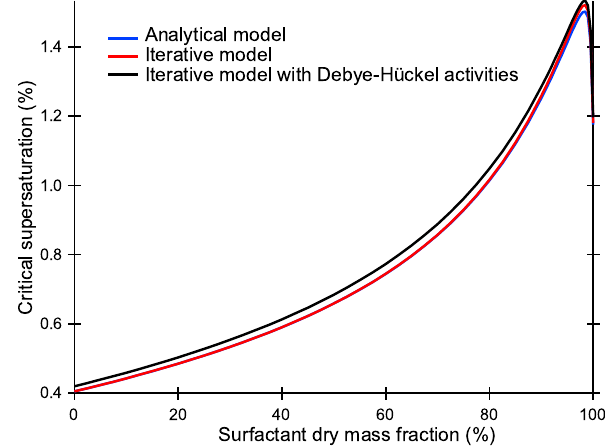
Fig. 2. Critical supersaturation for 40nm SDS-NaCl particles as a function of dry particle surfactant mass fraction. Model predictions are made with the analytical model and iterative model with and without activity coefficients.